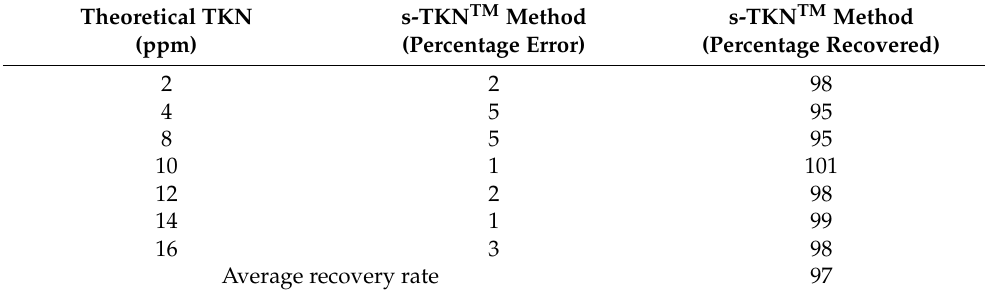
Table 2. Error rate and recovery rate of nitrogen using the simplified TKN method using Am-PTSA.